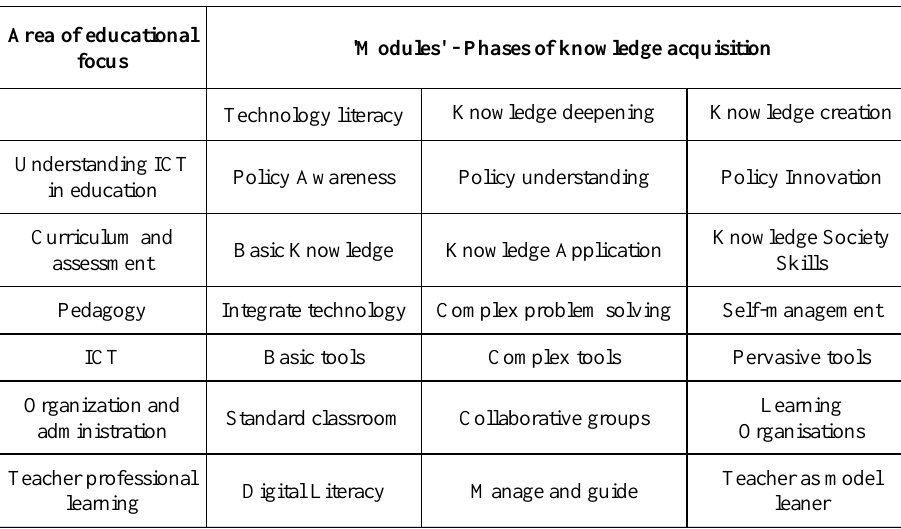
Table 2. UNESCO ICT competency framework for